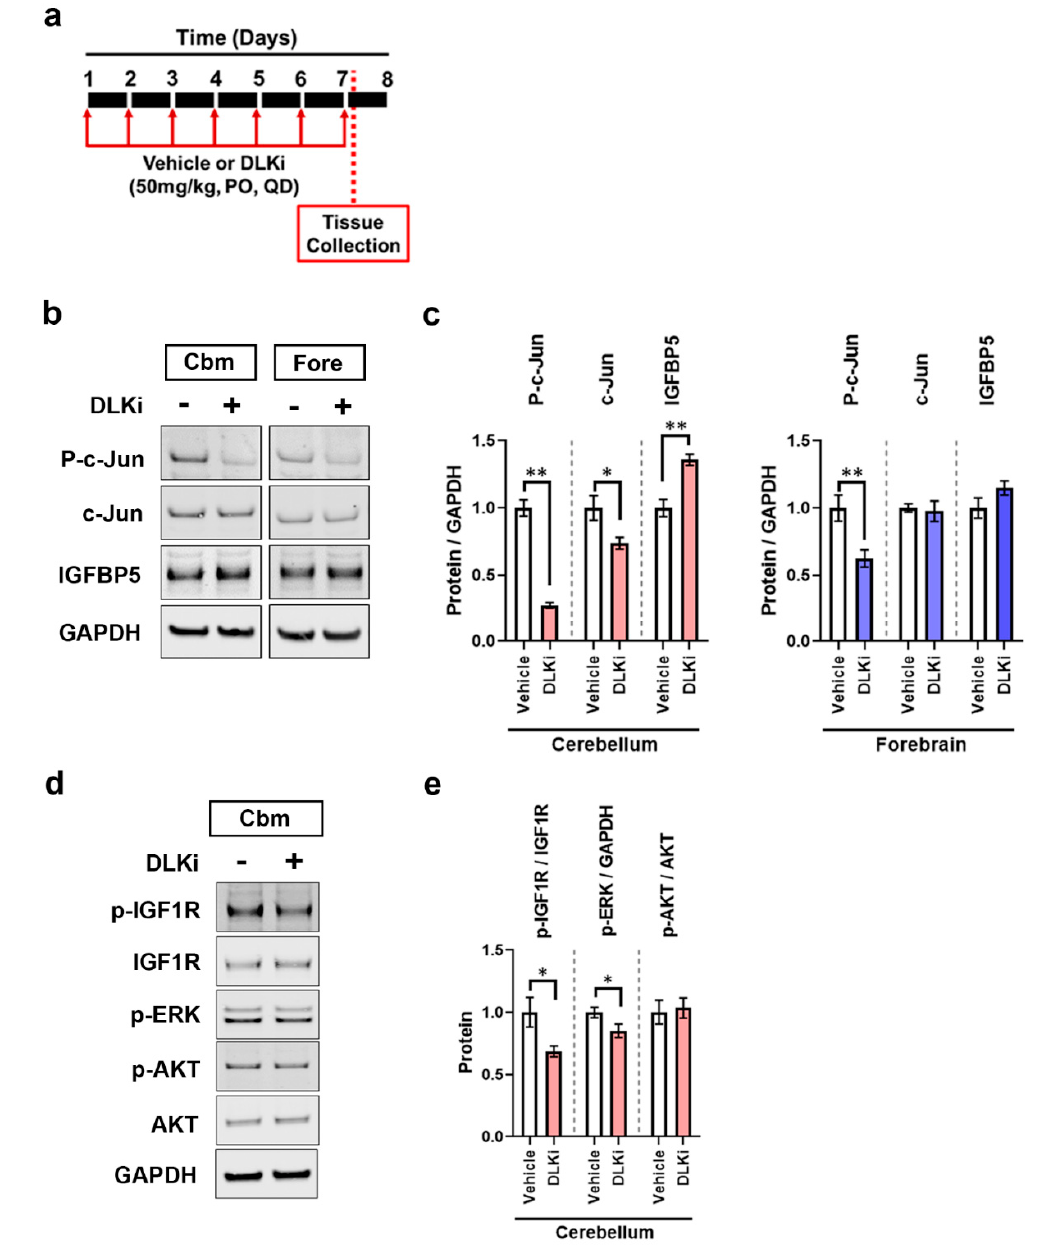
Figure 8. Sub-acute pharmacological inhibition of DLK modulates IGF1 binding protein-5 (IGFBP5) levels and IGF1 signaling in WT mice. ( a ) Schematic representation of study timeline; 3–4 months old male WT mice ( n = 8) were treated with 50 mg / kg of DLKi or vehicle QD for 7 days. The study was terminated approximately 2 h post final dose. ( b ) Representative immunoblots of p-c-Jun, c-Jun, and IGFBP5 in cerebellum (Cbm) and forebrain (Fore) homogenates of WT mice treated with vehicle or DLKi. ( c ) Quantification of the immunoblots of p-c-Jun / GAPDH, c-Jun / GAPDH, and IGFBP5 / GAPDH from cerebellum and forebrain homogenates of WT mice treated with vehicle or DLKi, plotted as mean fold change relative to vehicle group in respective brain region. Unpaired t -test. * p < 0.05, ** p < 0.01, n = 8. ( d ) Representative immunoblots of p-IGF1R, IGF1R, p-ERK, p-AKT, and AKT from cerebellum (Cbm) homogenates of WT mice treated with vehicle or DLKi. ( e ) Quantification of the immunoblots of p-IGF1R / IGF1R, p-ERK / GAPDH, and p-AKT / AKT from cerebellum homogenates of WT mice treated with vehicle or DLKi, plotted as mean fold change relative to vehicle group in respective brain region. * p < 0.05, unpaired t -test.